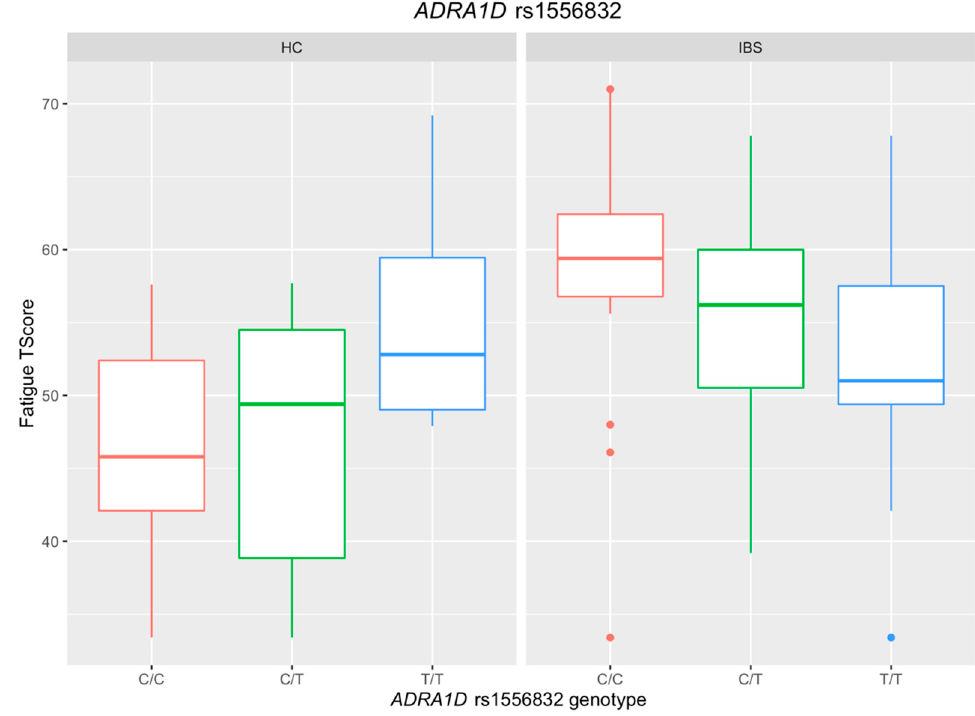
Figure 4. Association between ADRA1D rs1556832 and Fatigue in the IBS and the HC groups.